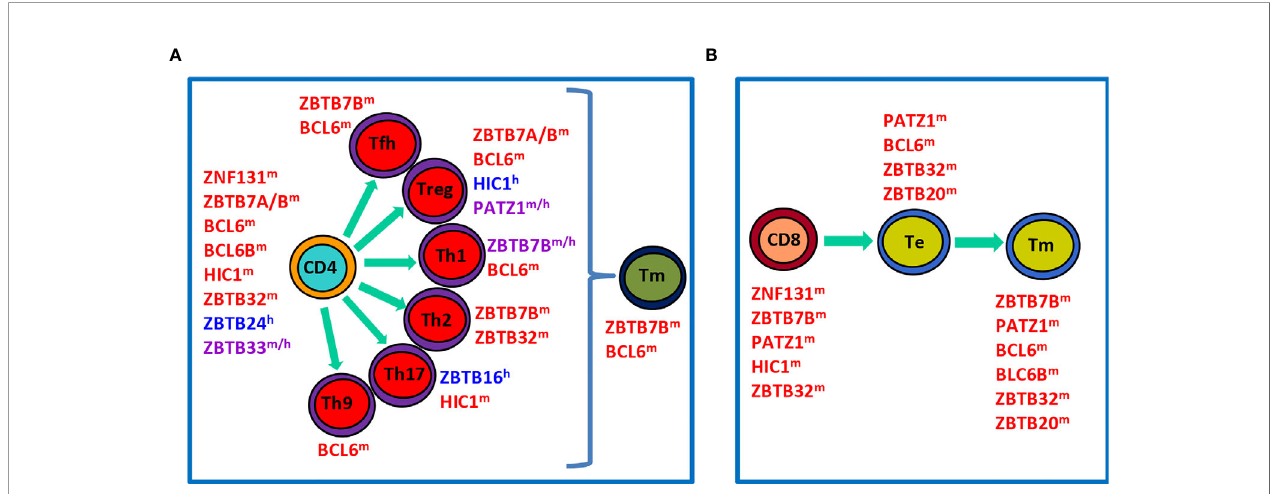
FIGURE 2 | Roles of ZBTB proteins in the proliferation, differentiation and function of conventional T cells in the periphery. (A), a schematic view showing that ZBTB proteins regulate the survival, proliferation and/or function of undifferentiated CD4 + T cells, differentiated effector Th subsets, or Tm cells. (B) , a schematic view illustrating roles of ZBTB proteins in CD8 + T cells along their differentiation into Te and fi nal Tm process. ZBTB proteins with the superscript ‘ m ’ , ‘ h ’ or ‘ m/h ’ in the upper right corner indicate that these proteins are ascribed to mice, humans or both,